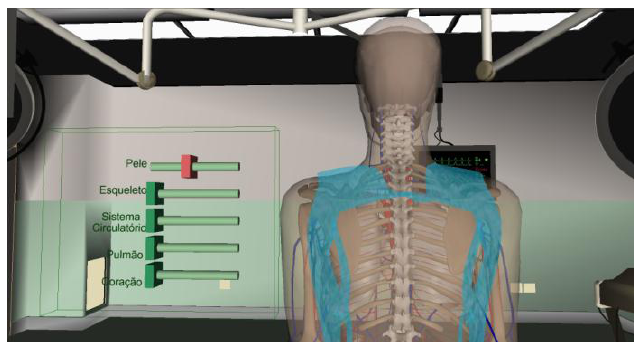
Fig. 7. Transparency selection in the model of the virtual